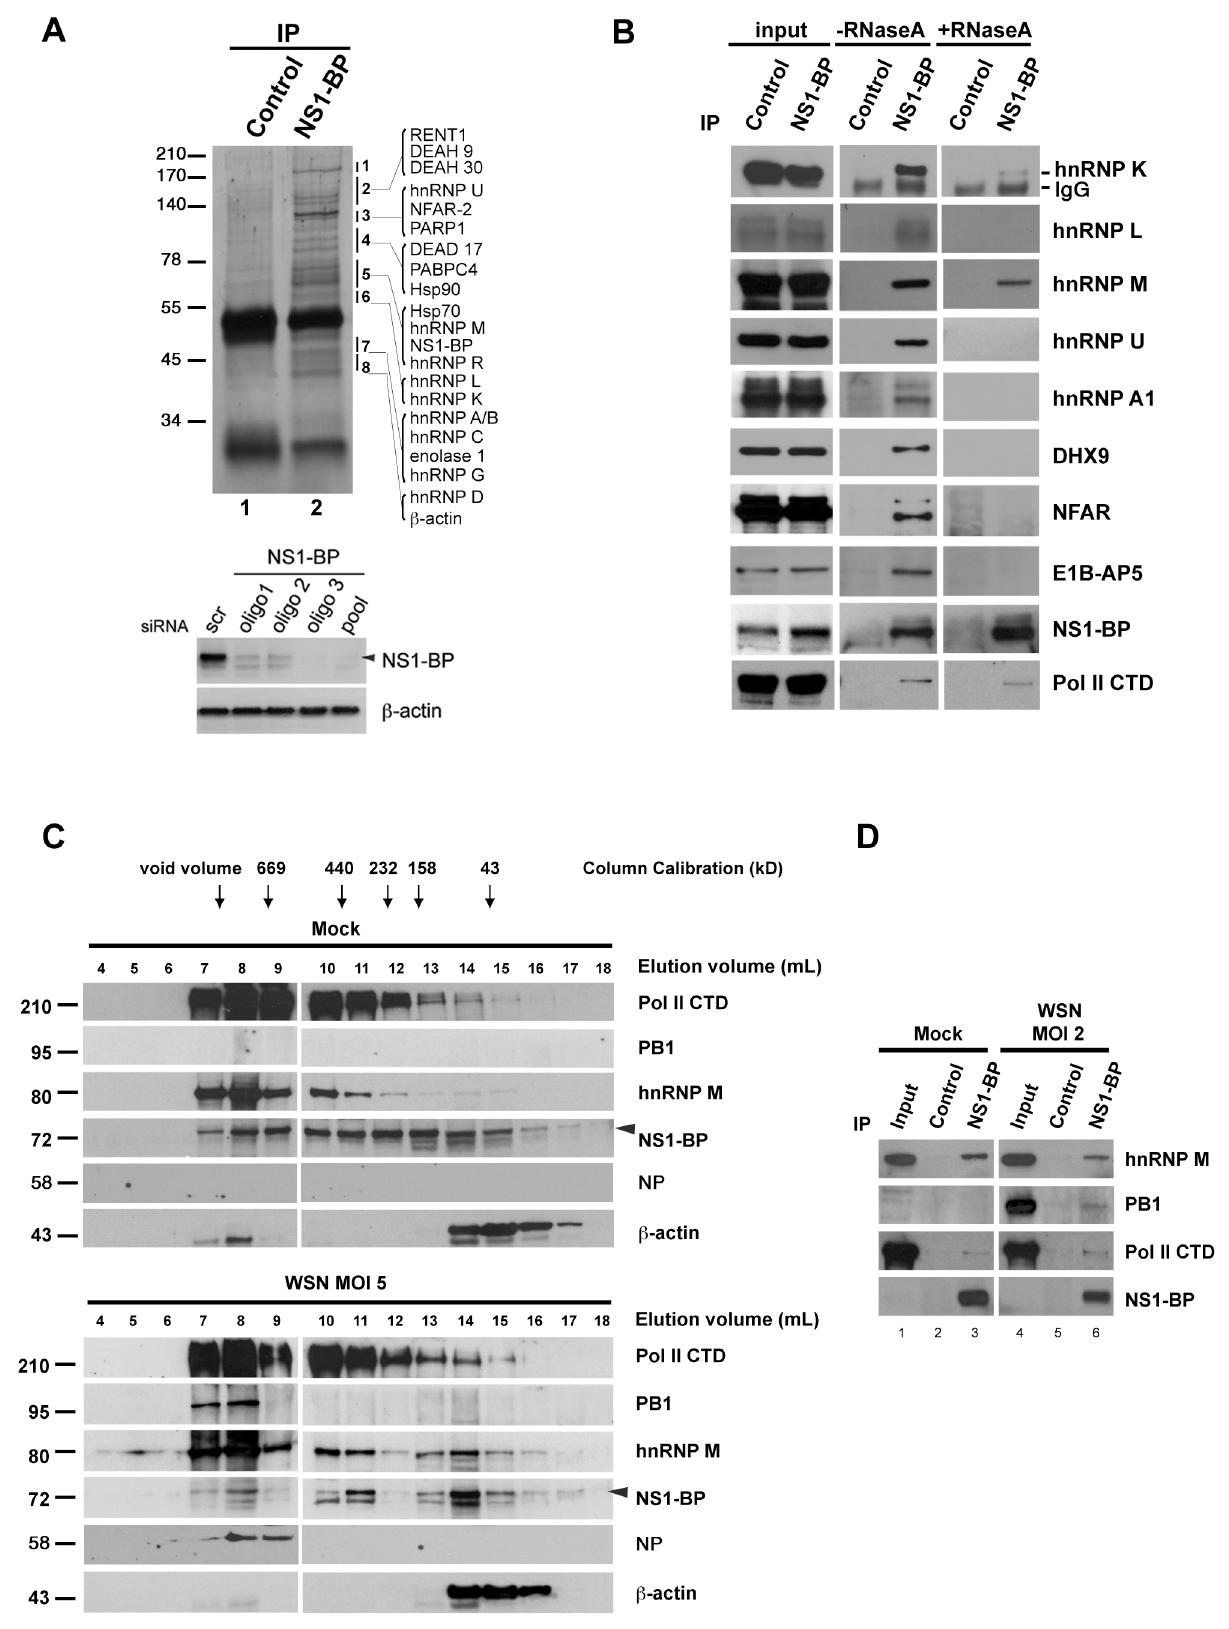
Figure 1. NS1-BP interacts with RNA-binding proteins, RNA polymerase II, and influenza A virus polymerase. (A) Top panel, HeLa cell lysates were immunoprecipitated with control IgG or NS1-BP antibodies. Interacting proteins were resolved by SDS-PAGE and identified by mass spectrometry. Bottom panel, A549 cells were treated with non-targeting or NS1-BP siRNAs (1, 2, and 3) for 48 h. Cell extracts were subjected to